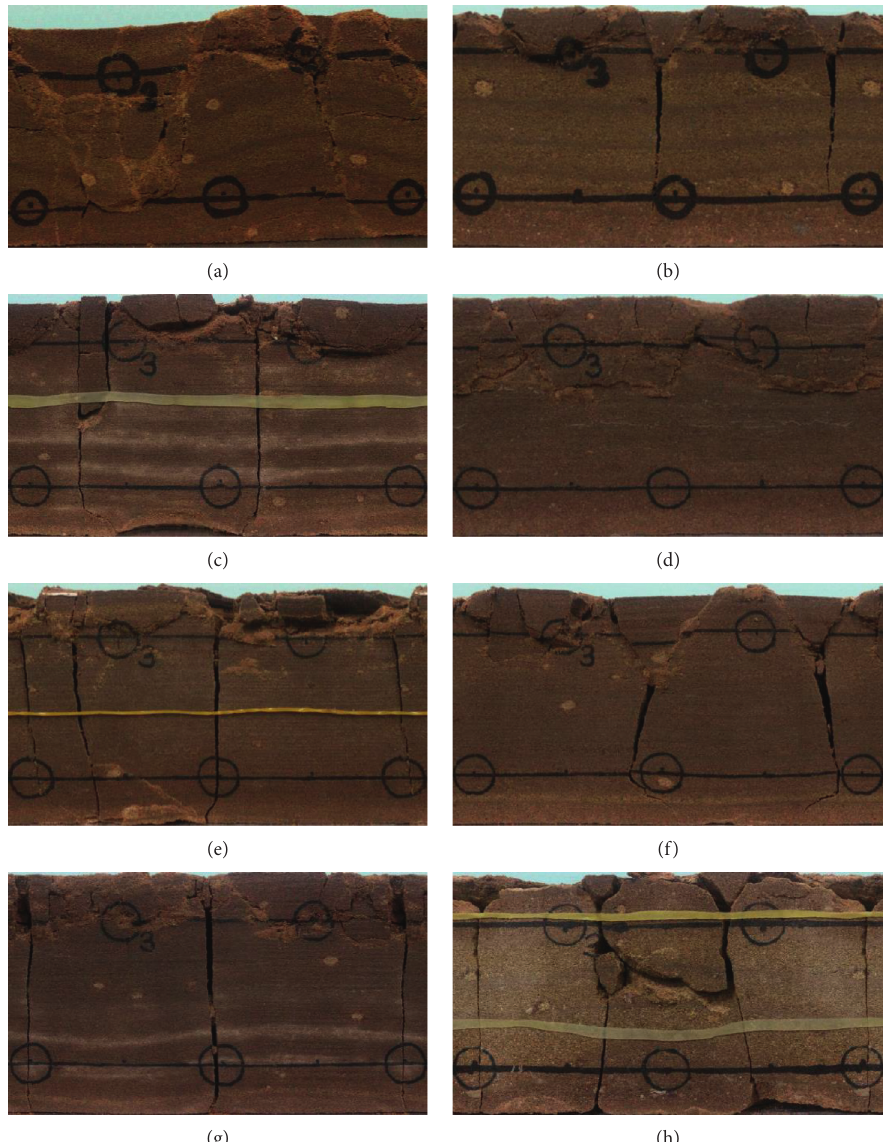
Figure 14: Side elevation view of frozen rock sample lateral unloading failure. (a) 20 ° C, σ